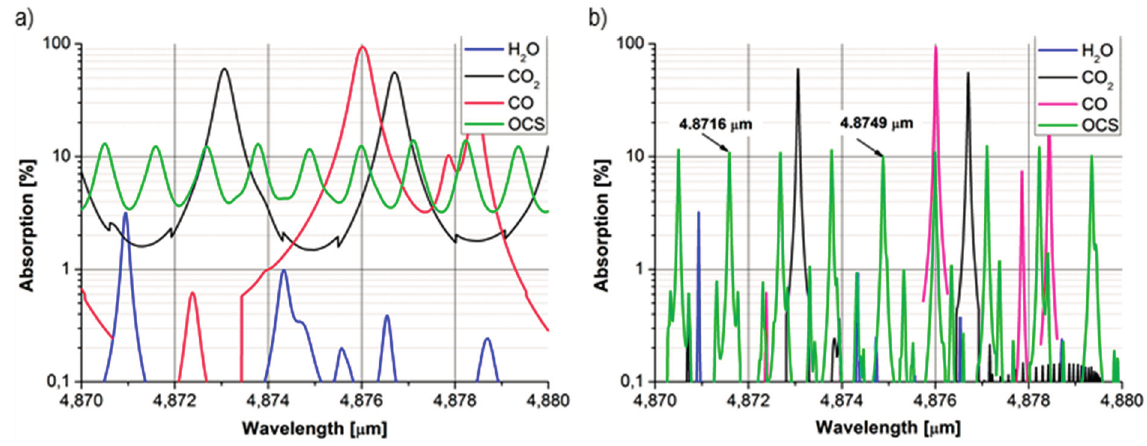
Figure 2. ( a ) The absorption of the OCS at pressures of 1 atm ( b ) and of 0.1 atm for concentrations occurring in human breath: OCS—10 ppb, CO—10 ppm, CO 2 —5%, H 2 O after the drying procedure—279